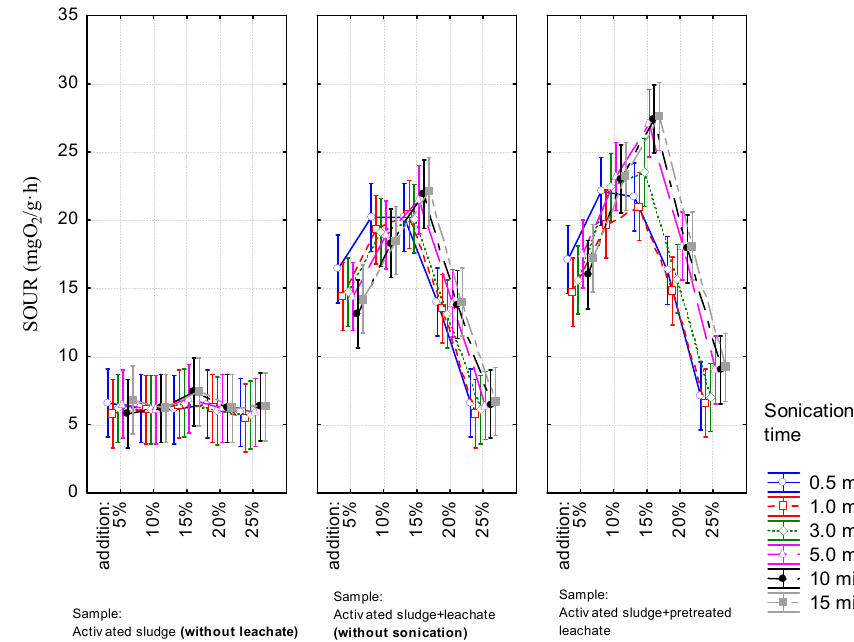
Figure 2. The SOUR profile at different the volumetric ratio of leachate in